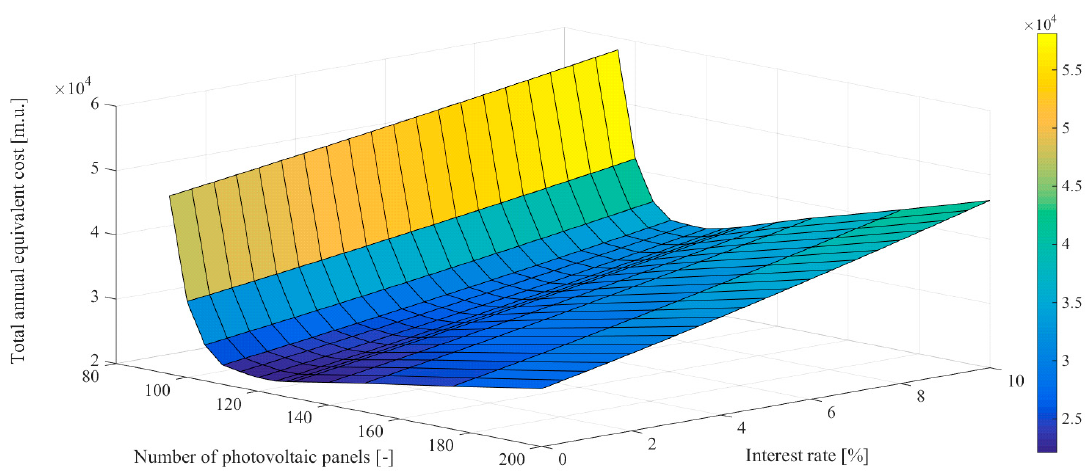
Figure 15. Equivalent annual total cost with respect to the interest rate without inflation and to the PVs population while the capacity of the 108 V AGM VRLA battery system is 2400 Ah.